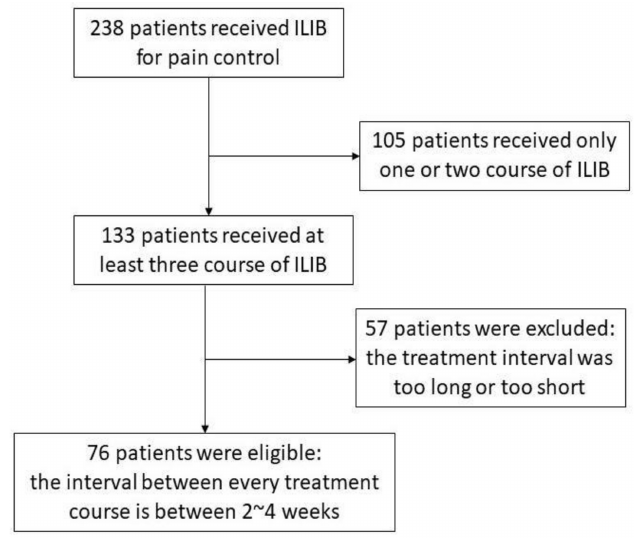
Figure 2. Patient inclusion flow